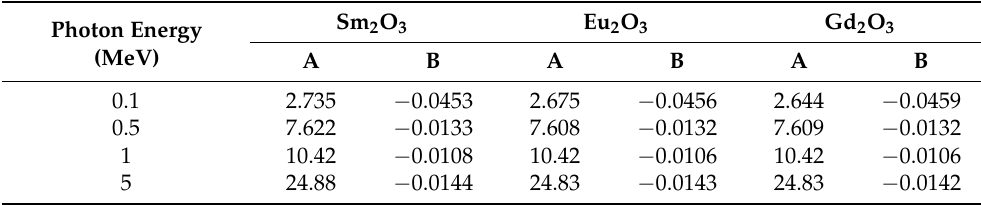
Table 6. Mathematical constants (A and B) of HVL in the form HVL = Ae Bx (Equation (6)) from Figure 6.